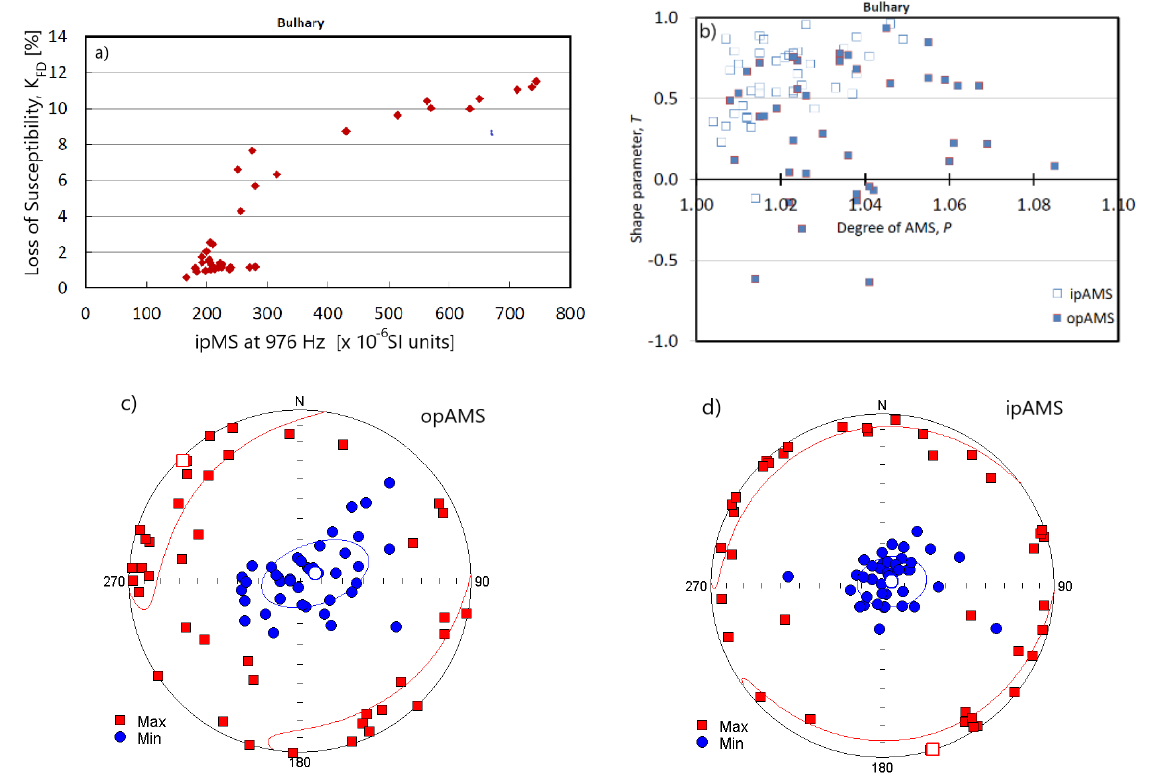
Figure 9. opAMS and ipAMS in loess/palaeosol sequence in Bulhary locality: ( a ) percentage loss of susceptibility ( K FD = 100 ( k 976 − k 15,616 )/ k 976 ) vs. ipMS, ( b ) P - T plot, ( c ) opAMS lineations (Max) and opAMS foliation poles (Min), ( d ) ipAMS lineations (Max) and ipAMS foliation poles (Min) in equal-area projection on lower hemisphere. Adapted from [19].